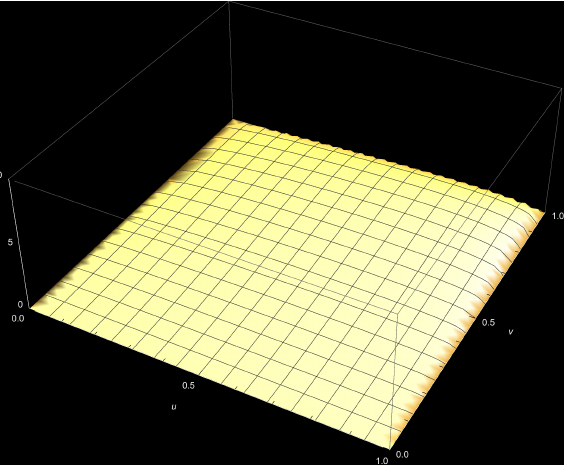
Figure A10. The bivariate Kumaraswamy contour (Equation (1)) plot, where α = 0.8, β = 0.8, θ = 4.5 and δ = 3.